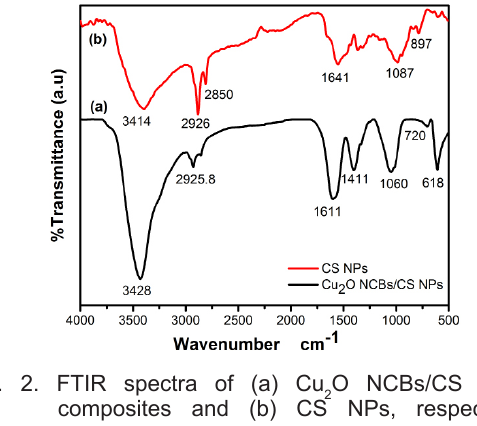
O NCBs/CS NPs 2